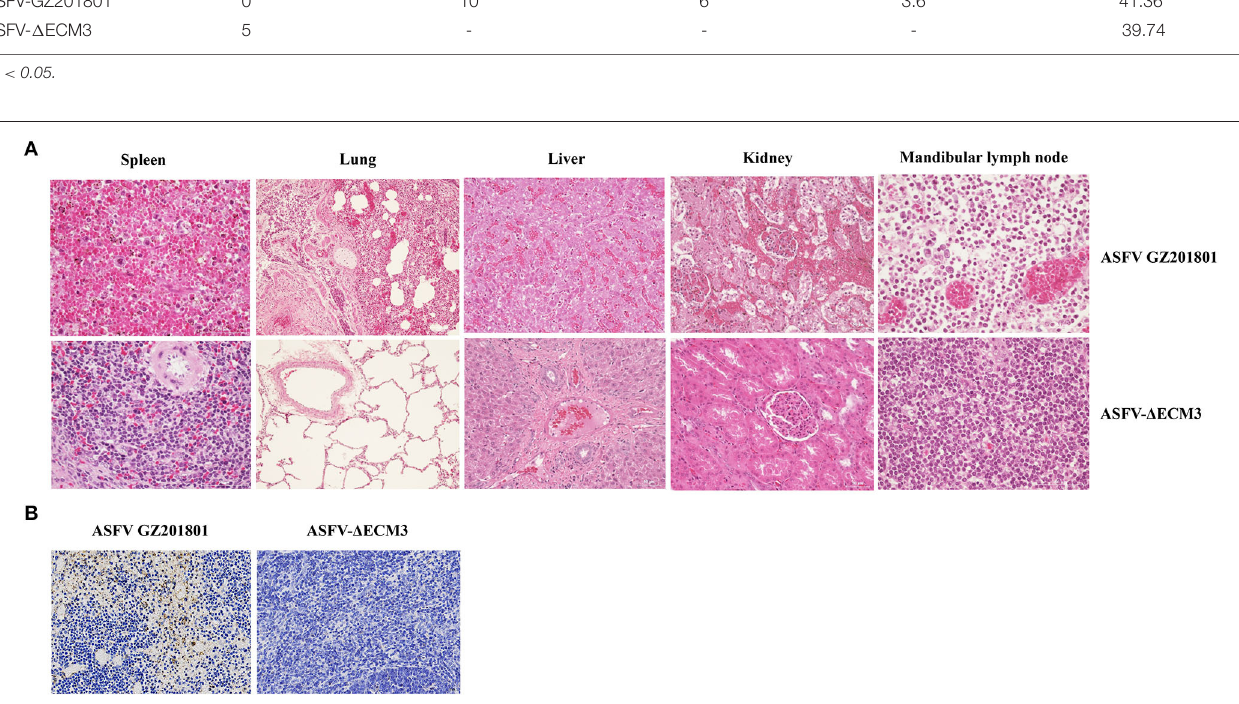
FIGURE 6 | Histological sections of the tissues by HandE staining and TUNEL assay. (A) Histopathological analysis of the spleen, lung, liver, kidney, and mandibular lymph node in the ASFV- 1 ECM3 virus and parental GZ201801 (H and E staining). (B) TUNEL assay of lymph